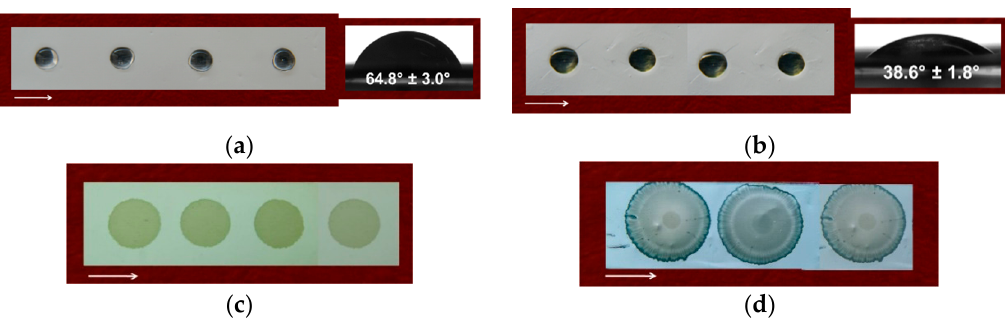
Figure 4. Digital images of water droplets (10 µL) deposited on the surfaces of fibrous mats from ( a ) cr(PVA/Ch), ( b ) cr(PVA/Ch)/SQ, ( c ) Cu 2+ complex of cr(PVA/Ch)/SQ and ( d ) Fe 3+ complex of cr(PVA/Ch)/SQ. The direction of the collector rotation is indicated by an arrow.